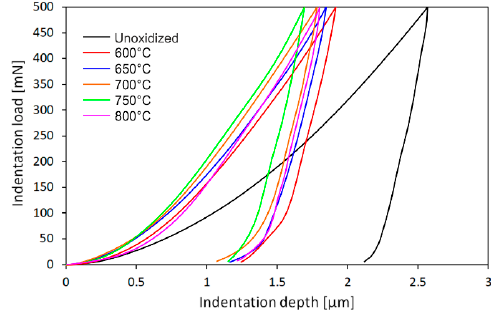
Figure 4. The constant peak-load of 500 mN for Ti-6Al-7Nb alloy, in the non-oxidized state and after oxidation at: 600 °C, 650 °C, 700 °C, 750 °C, and 800 °C (72 h).